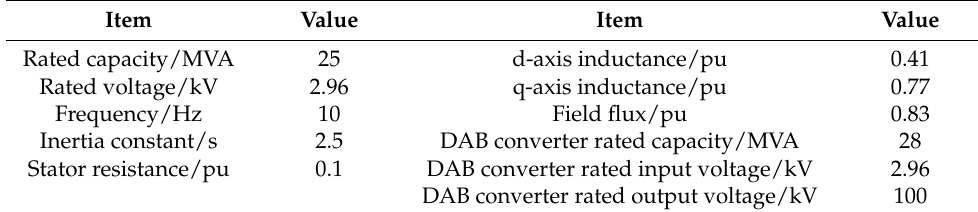
Table 2. Parameters of the aggregated WT.